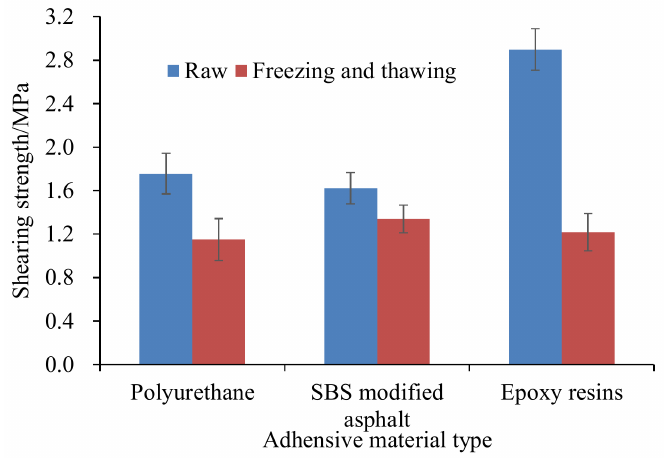
Figure 12. Shear strengths of PPM-10 + AC-20 composite specimen after freezing–thaw cycle with 0.5 mm adhesive